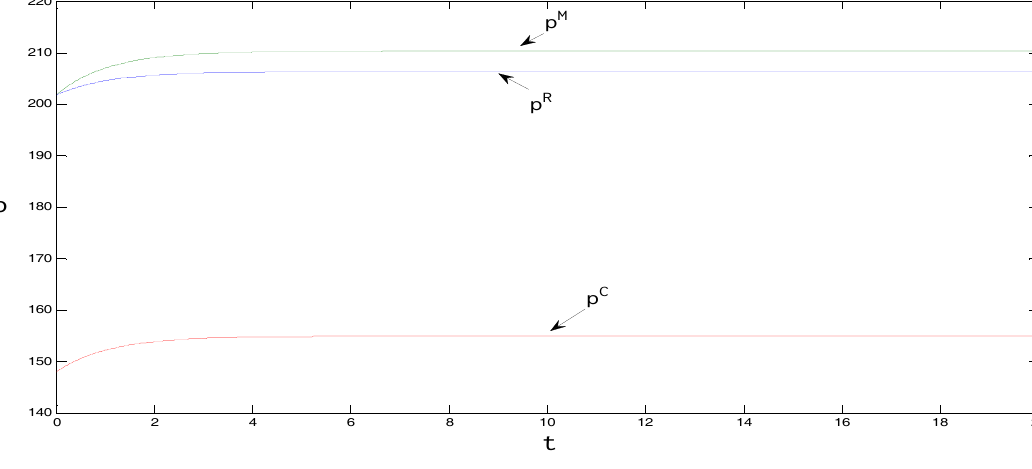
Figure 3. Comparison of market demand. 4.3. The Impact on Efforts Inference 6. The impact on the manufacturers’ carbon emissions reduction efforts, the retailers’ low ‐ carbon product promotion efforts is as follows: